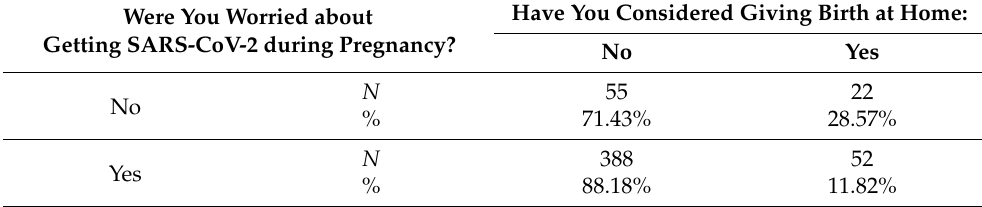
Table 4. The results of the analysis of the relationship between the fear of SARS-CoV-2 infection during pregnancy and the consideration of having a home